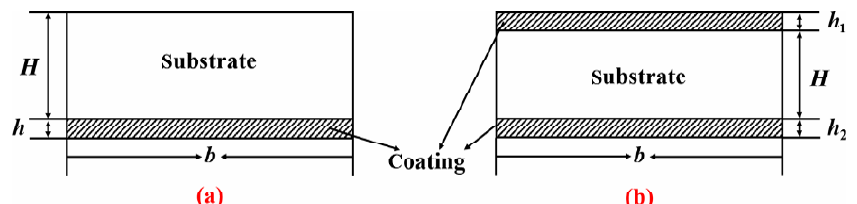
Fig. 2 Schematic illustration of cross-sections of beam specimens with different coating configurations: (a) single-face coating, (b) double-face coating.